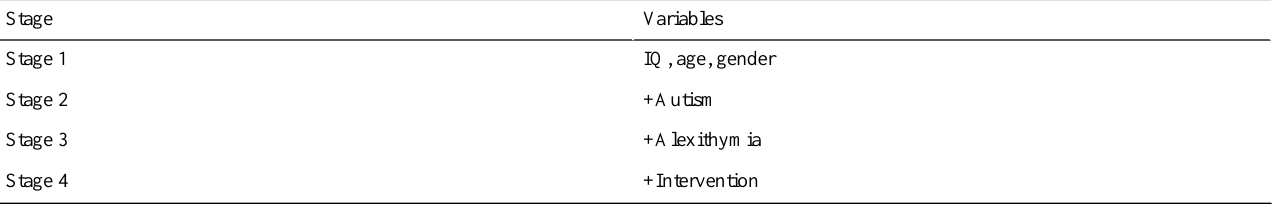
Table 3. Hierarchal regression stages for